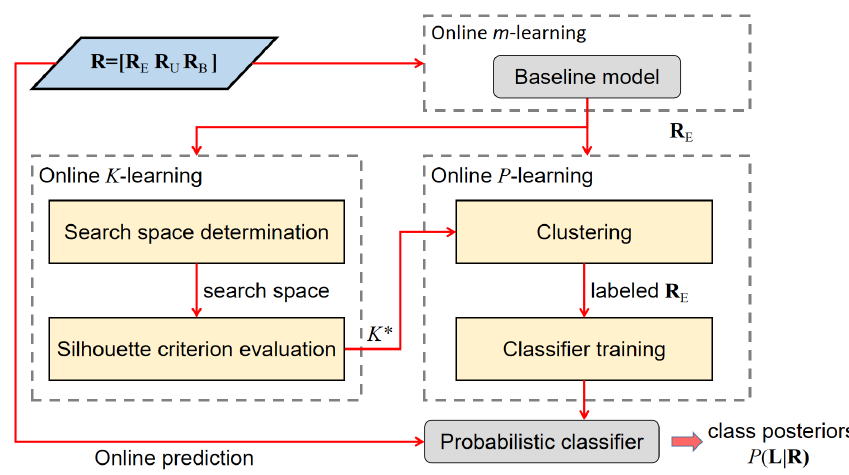
Figure 5. The diagram of the gas discrimination module. The learning path is triggered by the state machine, while the prediction path is used for all incoming